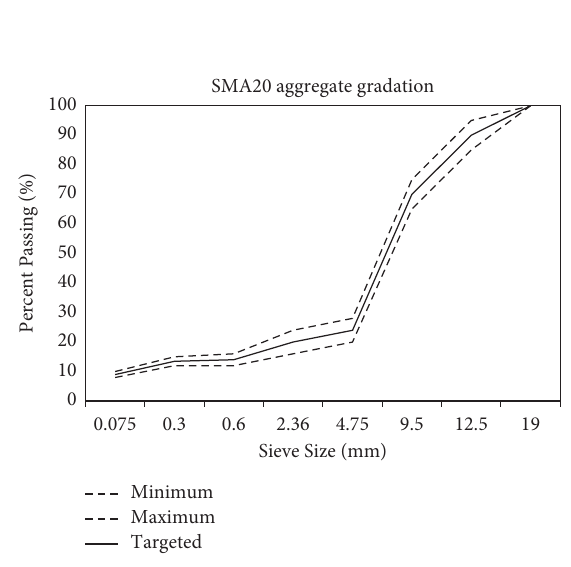
Figure 1: The SMA aggregate